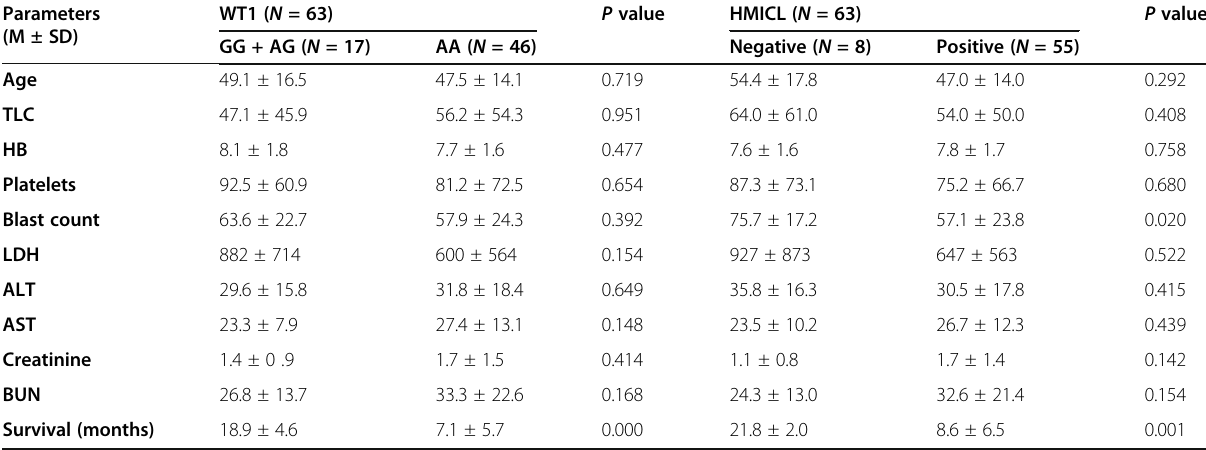
Table 6 Comparison between WT1 genotyping and hMICL expression to basal laboratory data of AML patients Parameters (M ± SD)